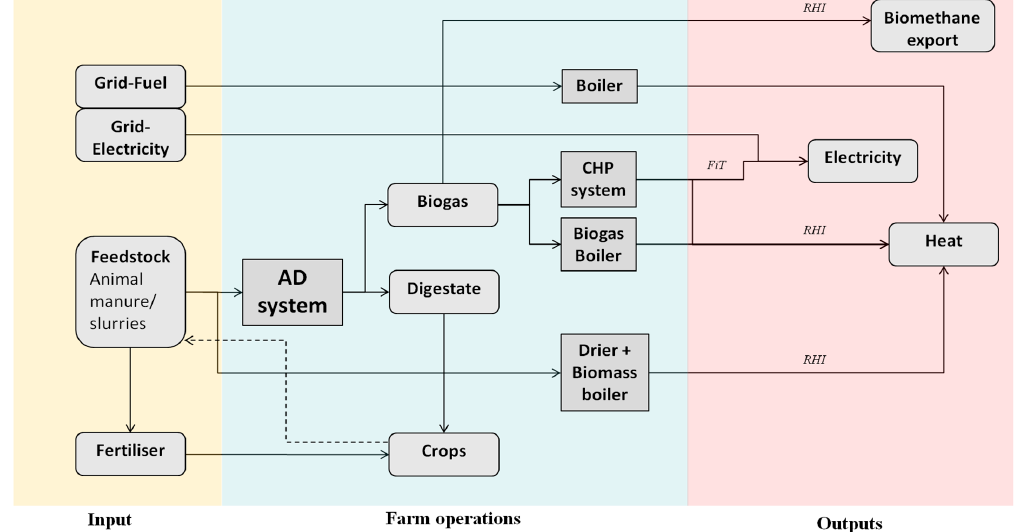
Figure 3. Technical information flow and applied incentives in GB farms. CHP: combined heat and power.